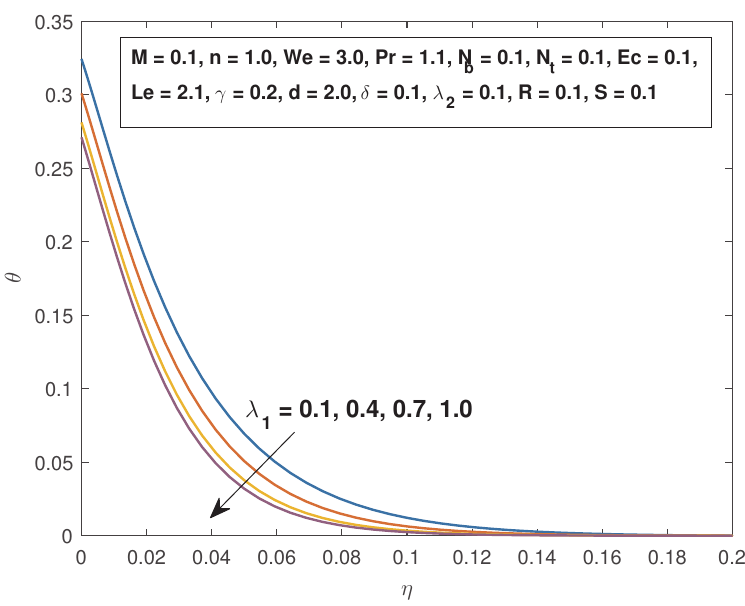
Figure 14. Influence of λ 1 on the fluid temperature.